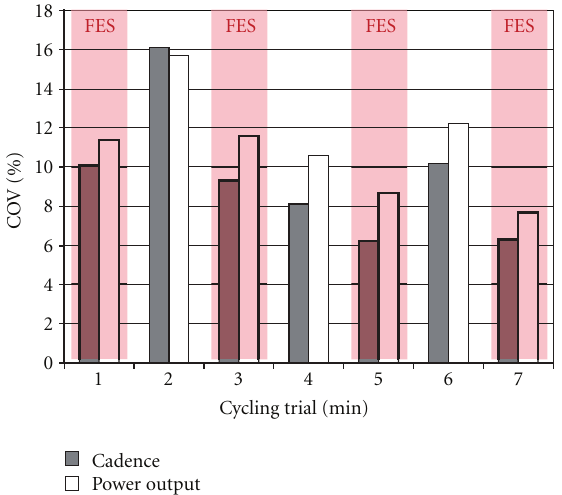
Figure 4: Coe ffi cient of variance of cycling cadence and power output during a constant load cycling test in an individual with CP who is adept at cycling (Participant 1). The coe ffi cient of variance for each variable was calculated over 1-minute periods in which FES assistance to the quadriceps muscles was either turned on (red shaded areas) or o ff (areas of the graph without red shading).